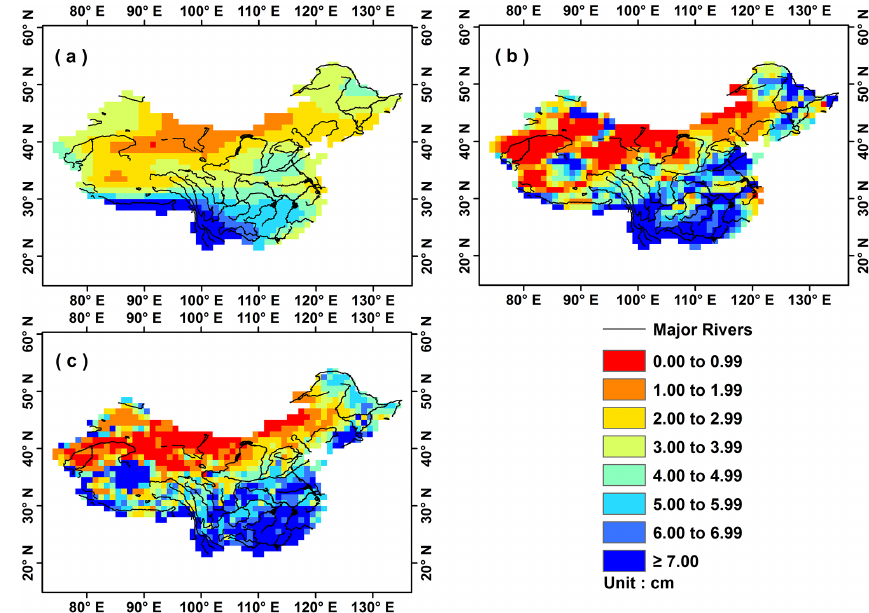
Figure 3. (a) Root-mean-square of TWS from the unscaled GRACE data, (b) the scaled GRACE data, and (c) the GLDAS ensemble mean. Table 5. Slopes of linear least squares fittings for basin-averaged TWS from the scaled and the unscaled GRACE data calculated in Eq. (4). Region HLJ LR HaiR HuaiR YR CJ ZJ SERs CHN Factor 1.26 1.10 1.32 1.57 1.08 1.34 1.19 R 2 0.996 0.989 0.988